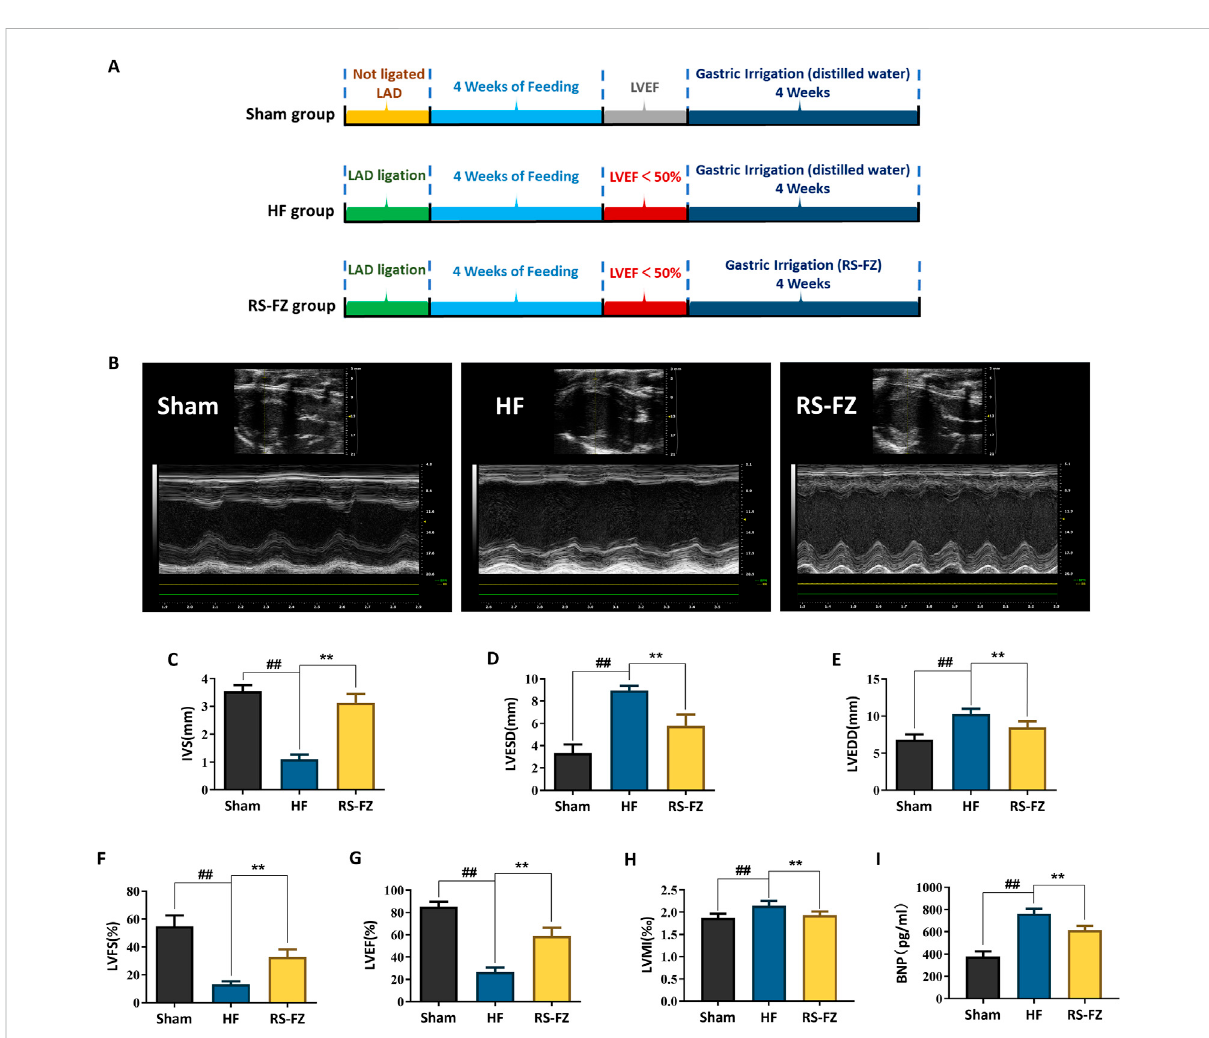
FIGURE 2 RS-FZ improved cardiac function of rats. (A) Experimental steps of HF model; (B) Representative M-mode echocardiographic images of Sham, HF model, RS-FZ group rats; (C) Ventricular septal thickness (IVS); (D) Left ventricular end-diastolic diameter (LVESD); (E) Left ventricular end- diastolicdiameter(LVEDD); (F) Leftventricularshortaxisshortening(LVFS); (G) Leftventricularejectionfraction(LVEF); (H) Leftventricularmassindex (LVMI); (I) The content of brain natriuretic peptide (BNP) in serum. Compared to Sham group, ## p < 0.01; Compared to HF model group, ** p < 0.01; All data expressed as mean ± SD, n = 8/group. Ligation of the anterior descending